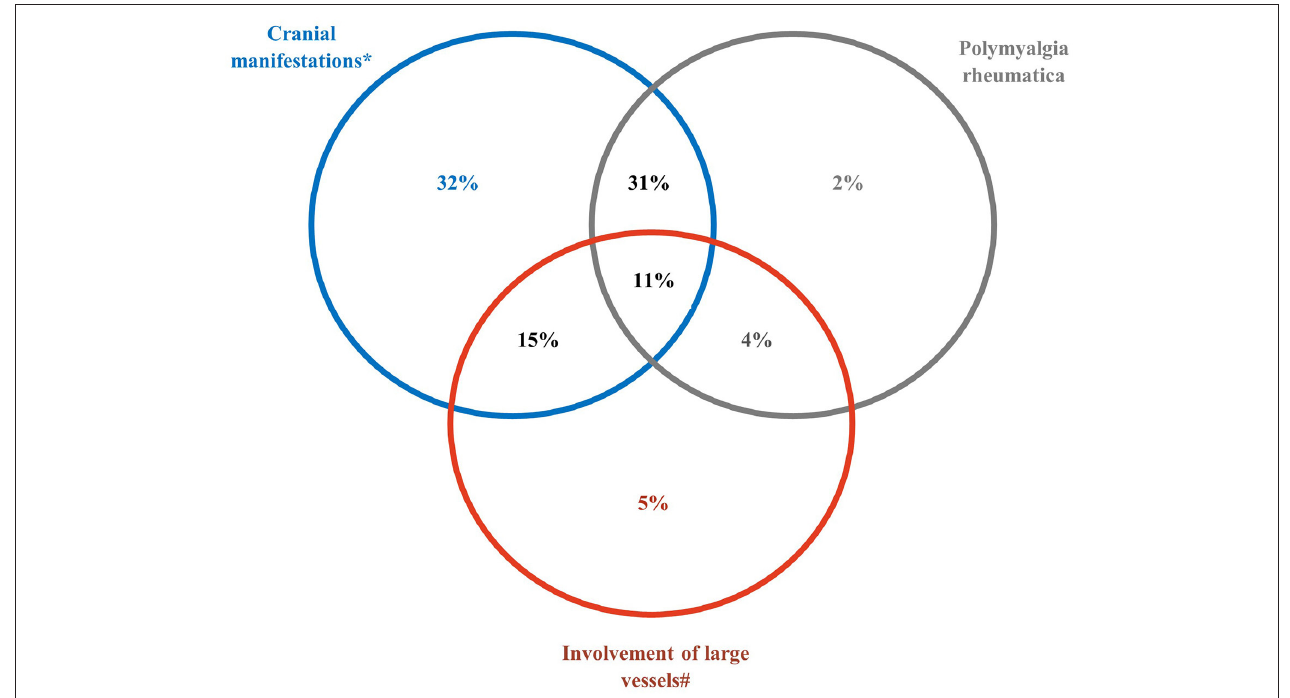
FIGURE 1 | Clinical phenotypes of giant cell arteritis at diagnosis. *The subset of cranial manifestations includes patients with strokes and transient ischemic attack(s). # The subset of large vessel involvement includes aortic aneurysm or dilatation, aortitis and/or involvement of aortic branch(s) in imaging, claudication of a limb, sign(s) of subclavian